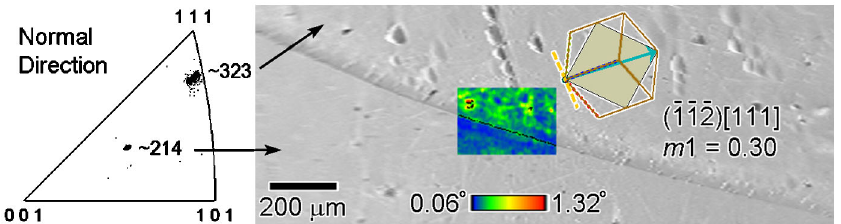
FIG. 14. The 3rd neighbor local average misorientation map for sample No. 1 overlapping the SEM image. The grain on the bottom with an orientation (cid:1)ð 214 Þk surface has fewer pits and lower (cid:2) values (sharper spot on inverse pole figure) than the grain on the top with orientation (cid:1)ð 323 Þk surface. The etch pits above the map correlate well with the plane trace of the most highly stressed slip system.